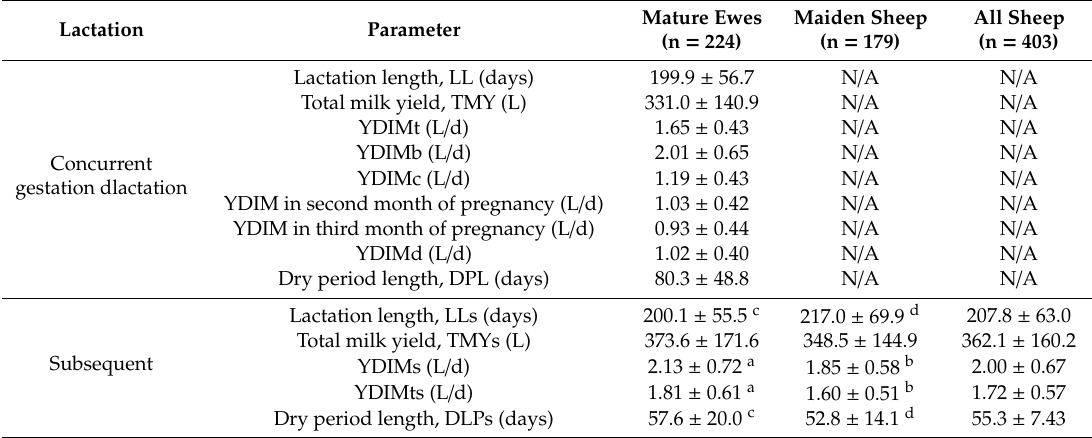
Table 1. Productivity parameters during concurrent gestation and lactation in mature ewes, and subsequent lactation in mature ewes and maiden sheep.